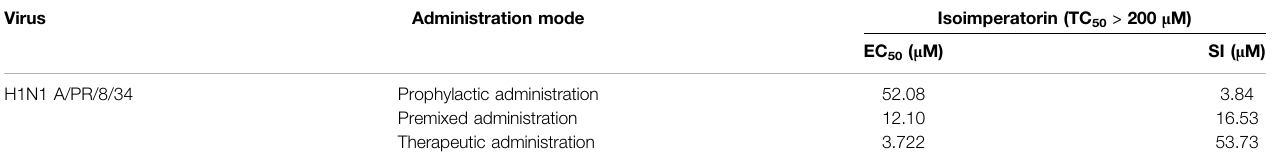
TABLE 1 | In vitro antiviral activity against H1N1 A/PR/8/34 by isoimperatorin with different medication modes. Virus